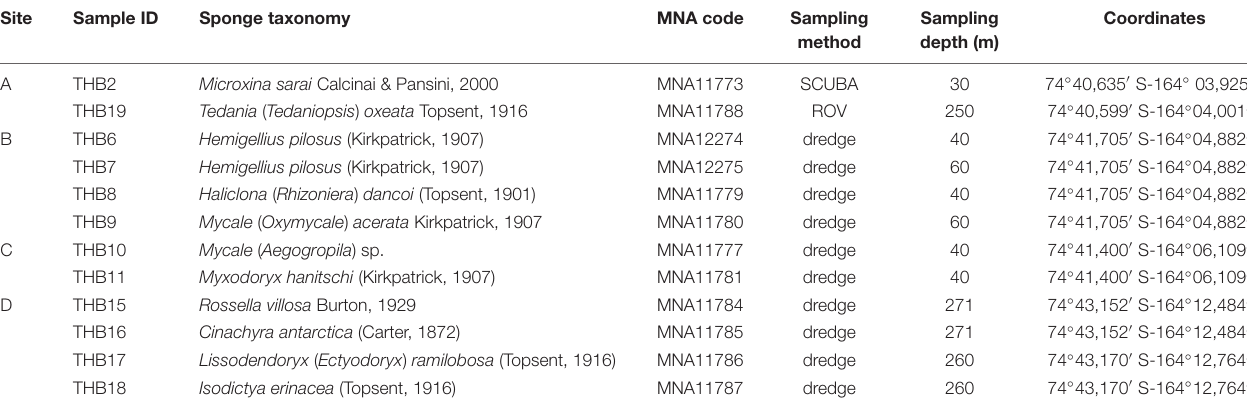
TABLE 1 | Sample identifiers, sponge identification, sampling site and depth, and